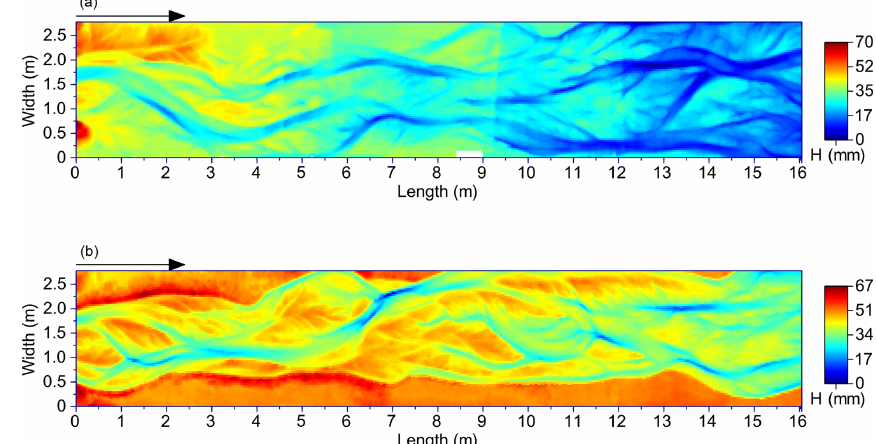
Figure 4. DEMs resulting from slightly out-of-focus images (a) compared to a DEM created under the same flow conditions with superior focus (b)